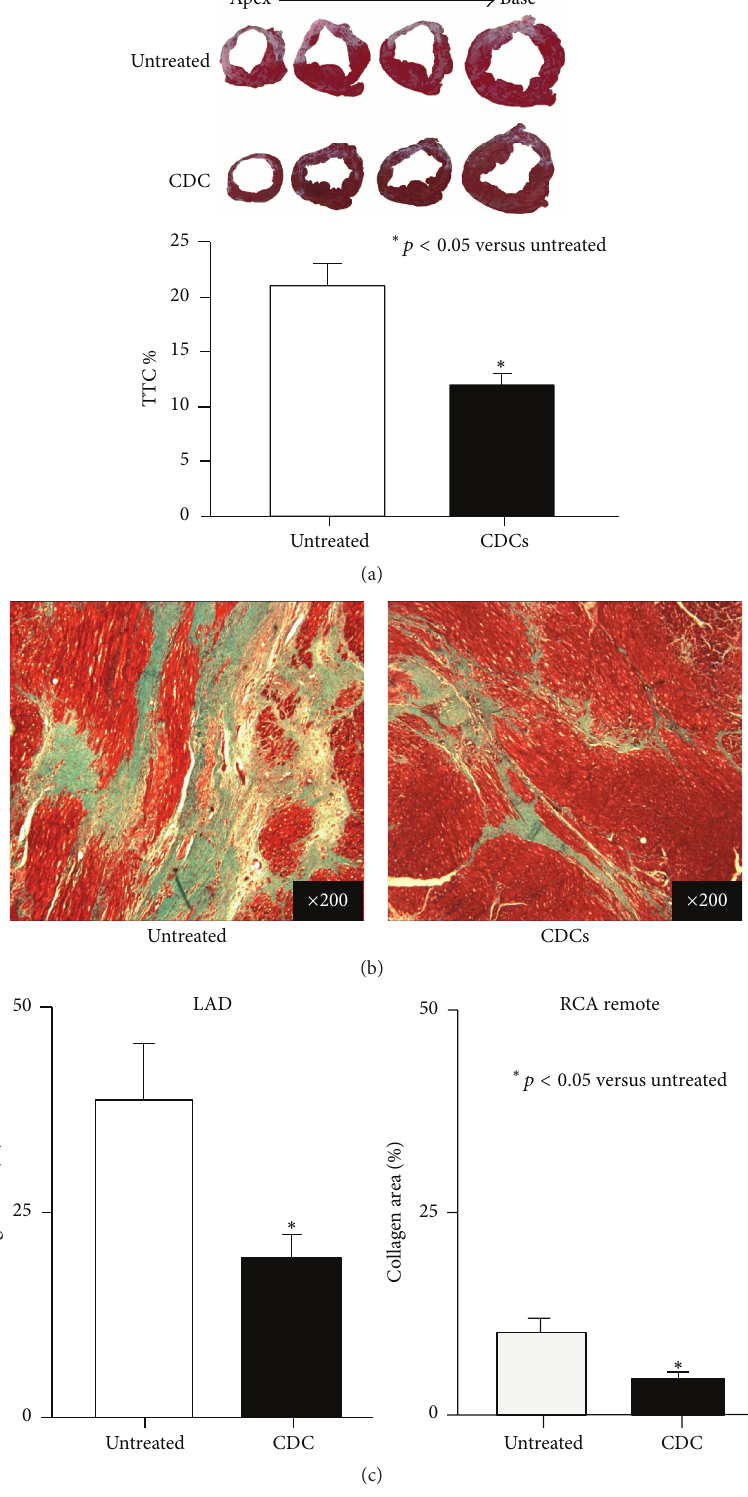
Figure 3: The effects of CDCs on infarction area and connective tissue area. (a) Postmortem analysis by TTC demonstrated that microembolization produced extensive myocardial infarction in anterior-septal region ( 21 ± 2 %). Global infusion of CDCs significantly reduced infarction area ( 12±1 %). Data indicate CDC infusion reduced infarction area and increased viable myocardium. (b) Masson staining demonstrates myocardial fibrosis (blue area) in myocardium (red area). Representative images demonstrate that CDCs significantly reduced fibrotic areas compared to untreated controls. (c) Global infusion of CDCs significantly reduced LAD fibrosis ( 39 ± 7 % to 19 ± 3 %, 𝑝 < 0.05 ) as well as in the RCA remote region ( 10 ± 2 % to 5 ± 1 %, 𝑝 < 0.05